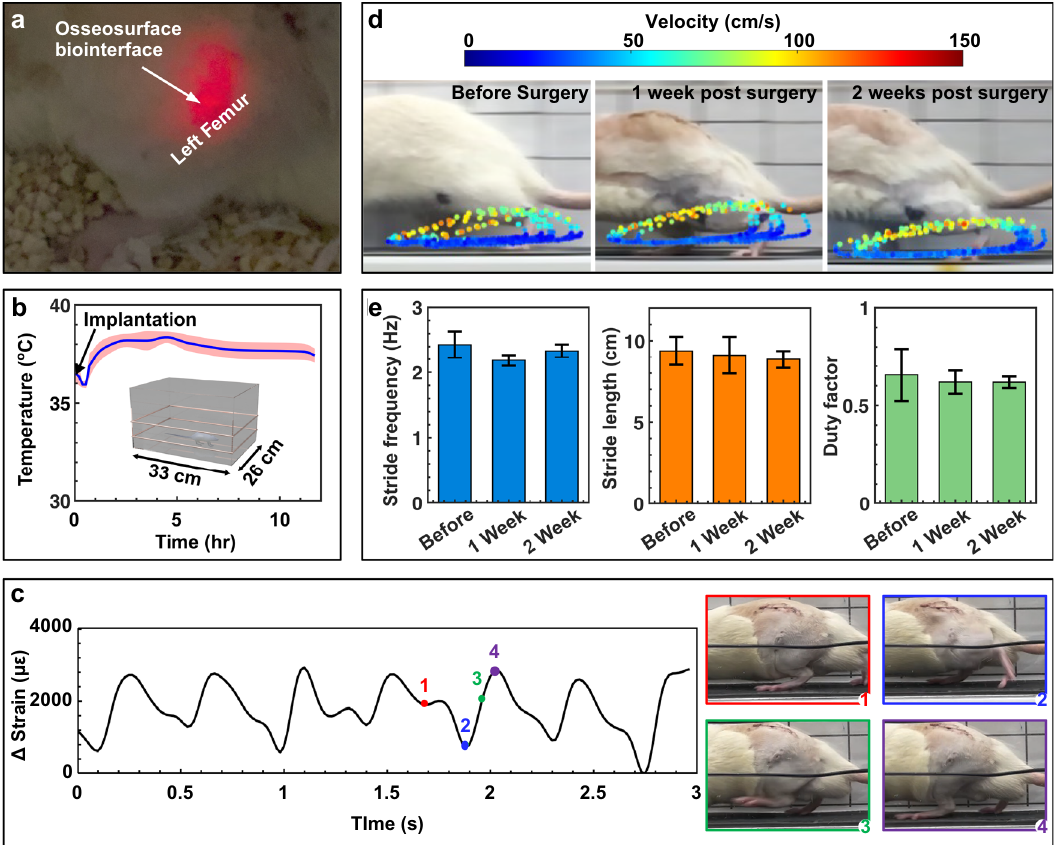
Fig. 5 In vivo studies of OSE in rats. a Photograph of the rear part of a rat featuring the µ -ILED attached on the femur illuminating through muscle and skin. b Temperature pro fi le recorded in vivo during the period of ~11.5 h following the implantation surgery. Inset, schematic of the rat residing in the home cage. c Time-synchronized strain recording and corresponding video frames of the rat gait cycle. d , e Comparison of the rat ’ s gaits at different stages of the study: before surgery, 1 week after surgery, and 2 weeks after surgery: photograph of rats walking on the treadmill overlaid with the trajectory of the ankle. Color of the dots represents the velocity of the ankle ( d ). Key parameters: stride frequency (before: mean = 2.4293, SD = 0.4057, n = 7; 1 week: mean = 2.1843, SD = 0.1692, n = 7; 2 week: mean = 2.3336, SD = 0.197, n = 7); stride length (before: mean = 9.3812, SD = 1.749, n = 7; 1 week: mean = 9.1175, SD = 2.2686, n = 7; 2 week: mean = 8.8466, SD = 1.0577, n = 7); and duty factor (before: mean = 0.6558, SD = 0.2689, n = 7; 1 week: mean = 0.6189, SD = 0.118, n = 7; 2 week: mean = 0.6182, SD = 0.0585, n = 7) that characterizes the rat gait before and after implantation ( e